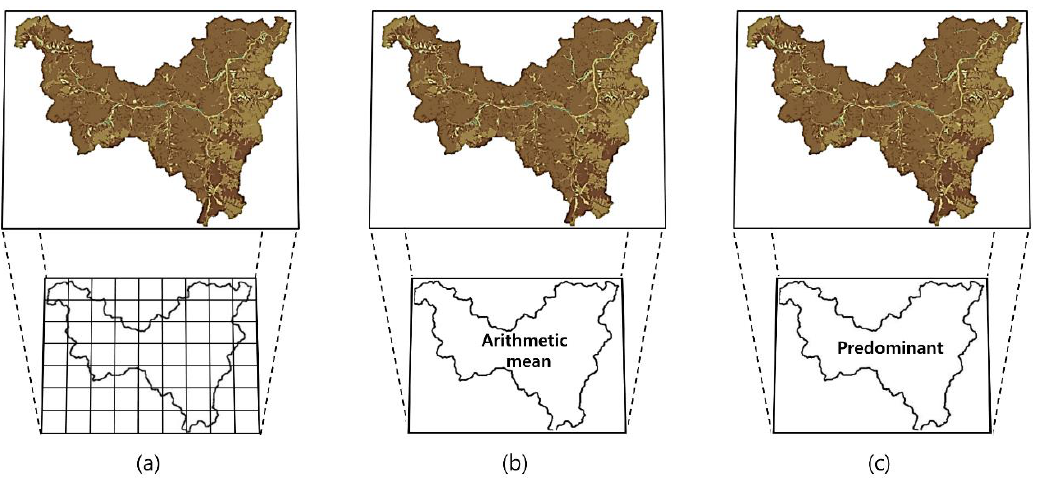
Figure 2. Approaches to specifying hydrologic parameters: ( a ) mosaic, ( b ) arithmetic mean, and ( c ) predominant.